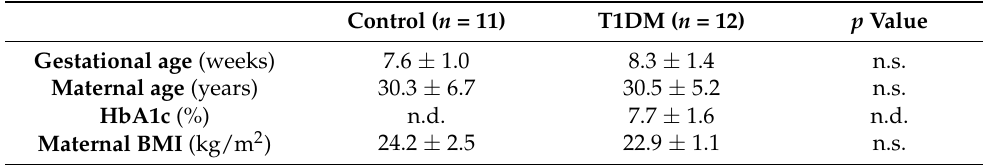
Table 1. Characteristics of the study cohort used in the protein